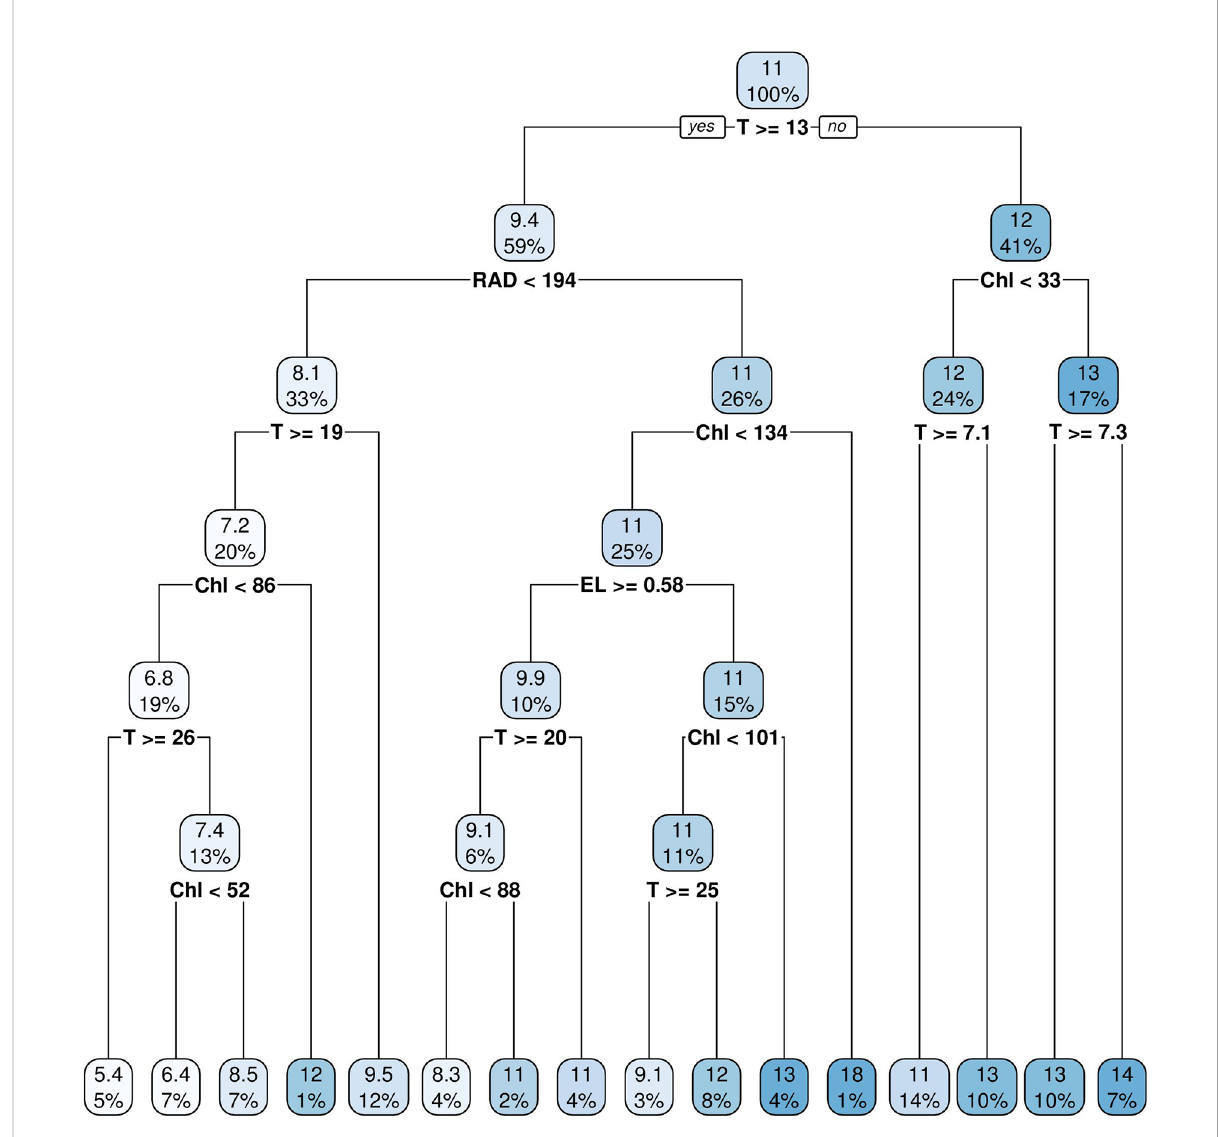
FIGURE 8 Classi fi cation And Regression Tree (CART) analysis of DO simulation time-series data at the upper estuary station XHH3851. Independent variables are water temperature (T), chlorophyll concentration (Chl), sea surface elevation (EL) and solar radiation